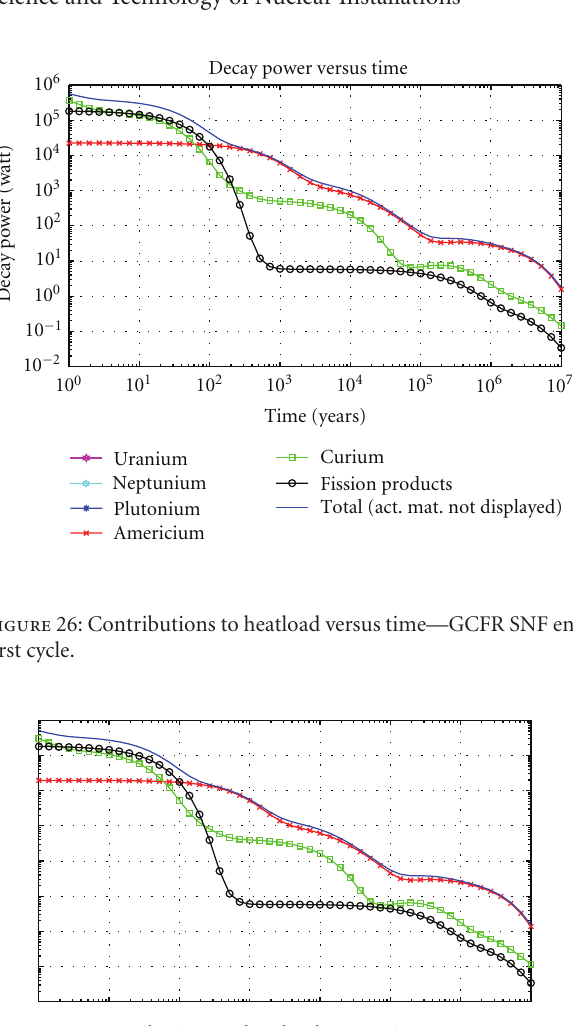
Figure 27: Contributions to heatload versus time—GCFR SNF end second cycle.